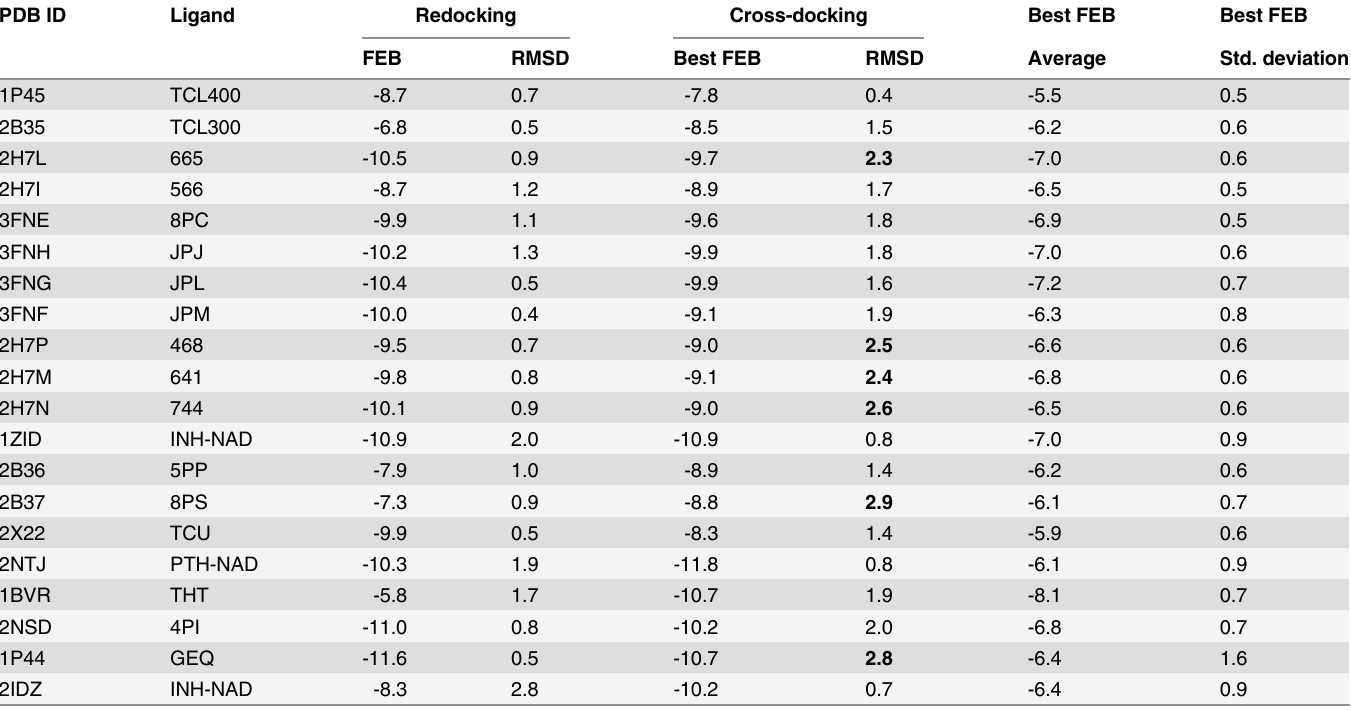
Table 2. Summary of docking experiments performed to analyze the clustering results. The sixth column highlights the cross-docking experiments that showed RMSD values above 2.0 Å for the best FEB values (kcal/mol). For comparison, the third and fourth column indicates docking results (FEB and its corresponding RMSD) obtained by reproducing the original pose of the ligand in its crystal